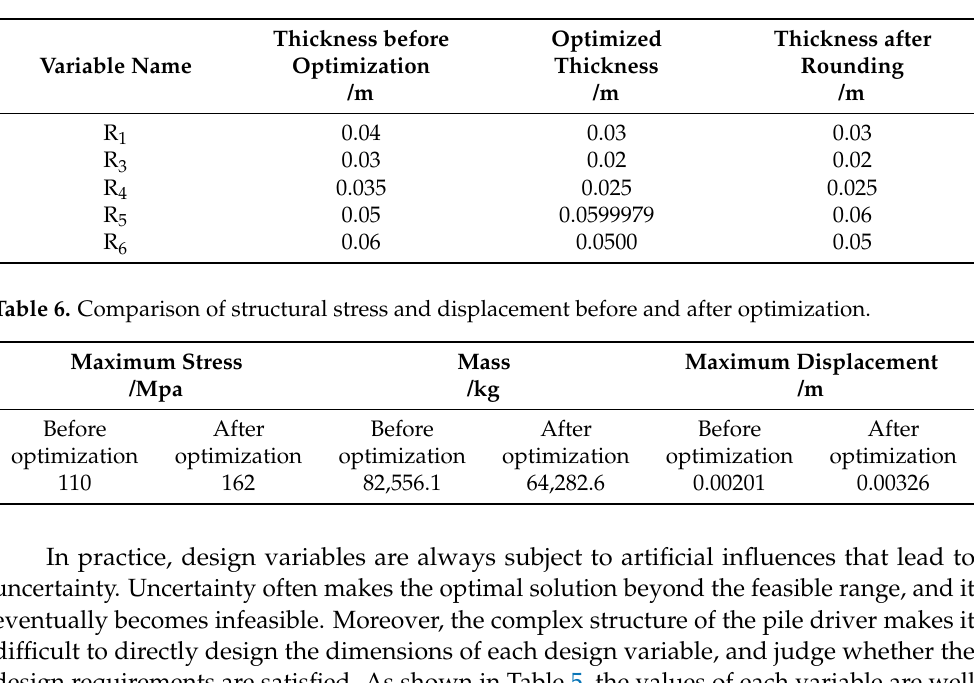
Figure 9. The value of each variable in the optimization. ( a ) The value of R 1 ; ( b ) the value of R 3 ; ( c ) the value of R 4 ; ( d ) the value of R 5 ; ( e ) the value of R 6 ; ( f ) the value of stress; ( g ) the value of displacement; ( h ) the value of mass. Table 5. Design variables before and after optimization and rounding thickness after optimization.